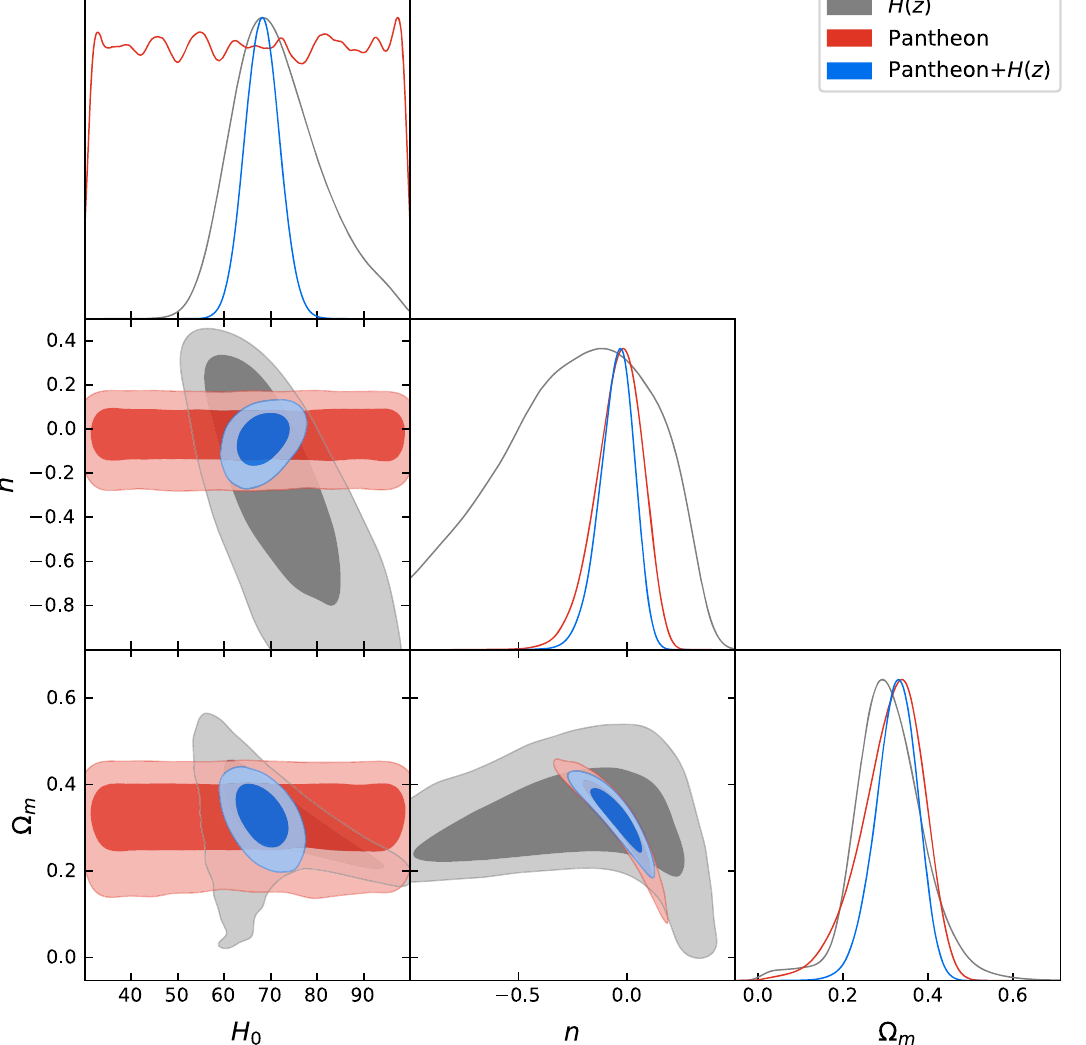
Fig. 1 Case I: Contours of the parameters H 0 , (cid:7) m and n at 1 σ and 2 σ c.l. for the separate set of data of H ( z ) (grey) and SNe Ia – Pantheon (red), and for the joint analysis